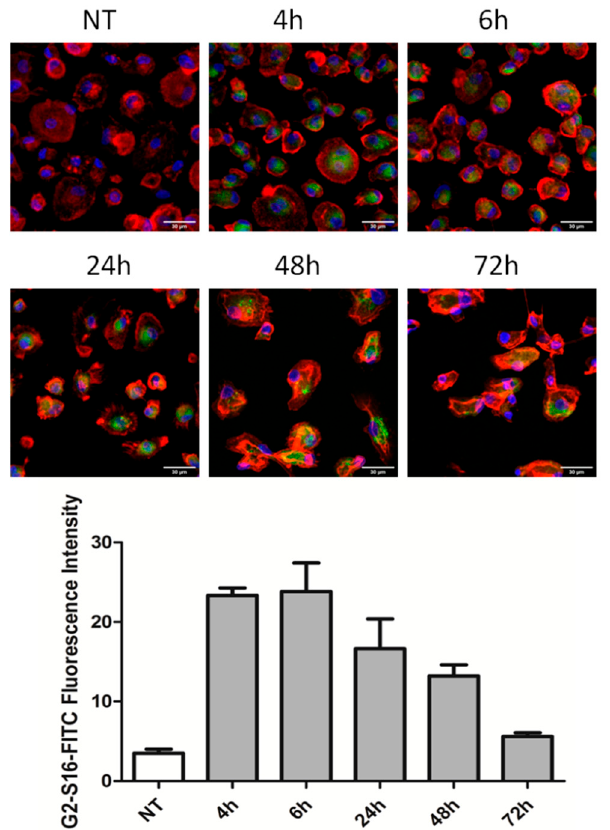
Figure 1. Representative confocal images of G2-S16 internalization in MDMs. Human monocytes were isolated and differentiated to MDMs. After differentiation, MDMs were treated with G2-S16-FITC for 2 h and washed with glycine (pH 3) to detach all non-internalized dendrimer in the cell membrane and washed 3 times with PBS. Confocal images were taken at 4, 6, 24, 48, and 72 h after treatment. FITC fluorescence was measured and is represented in the bars. Red: cell membrane. Blue: cell nuclei. Green: G2-S16-FITC dendrimer. Representative images of 3 independent experiments are shown.